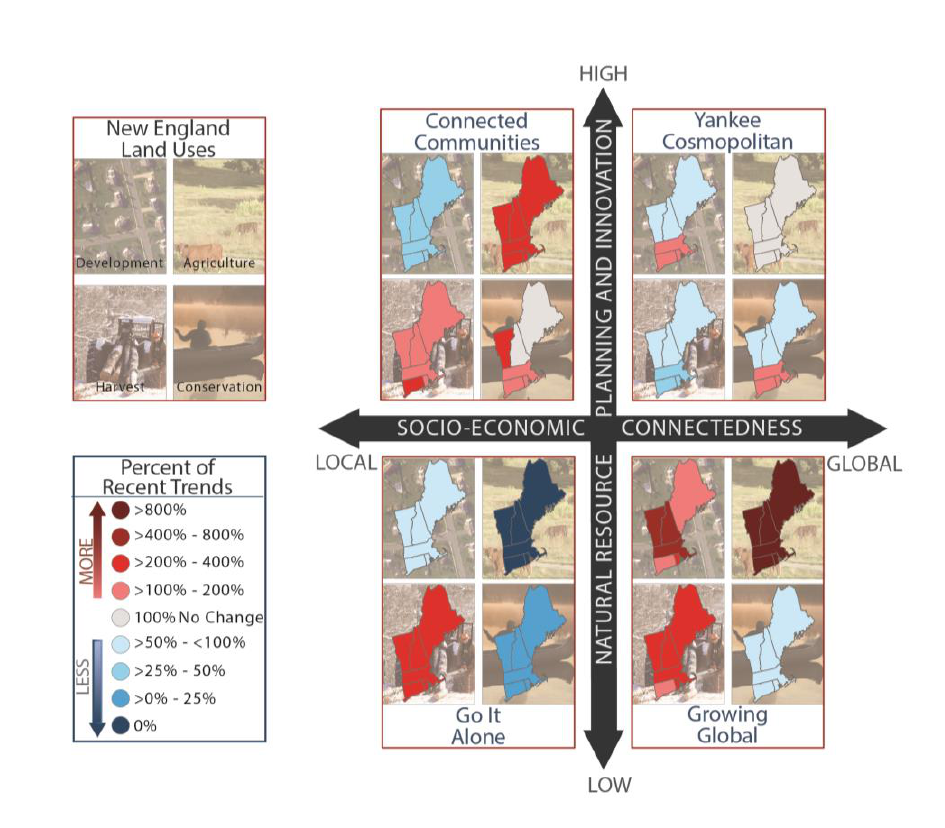
Fig. A3.2. Land cover and land use change by